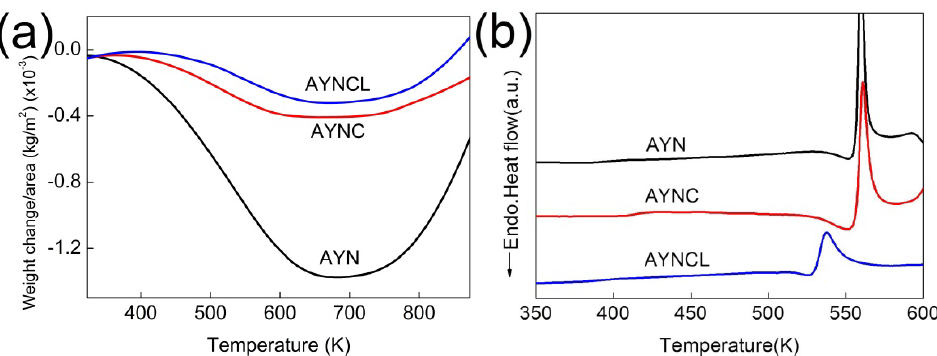
Figure 1. Weight change per unit area of the three ribbons (Al 85.4 Y 10 Ni 5.5 (AYN), Al 85 Y 8 Ni 5 Co 2 (AYNC), and Al 86 Y 6 Ni 4.5 Co 2 La 1.5 (AYNCL)) measured by ( a ) TGA and ( b ) DSC analysis of the three